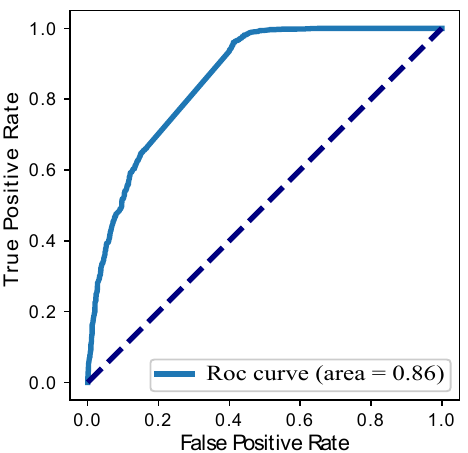
Figure 15. Receiver Operating Characteristic (ROC) curve of BGRU.